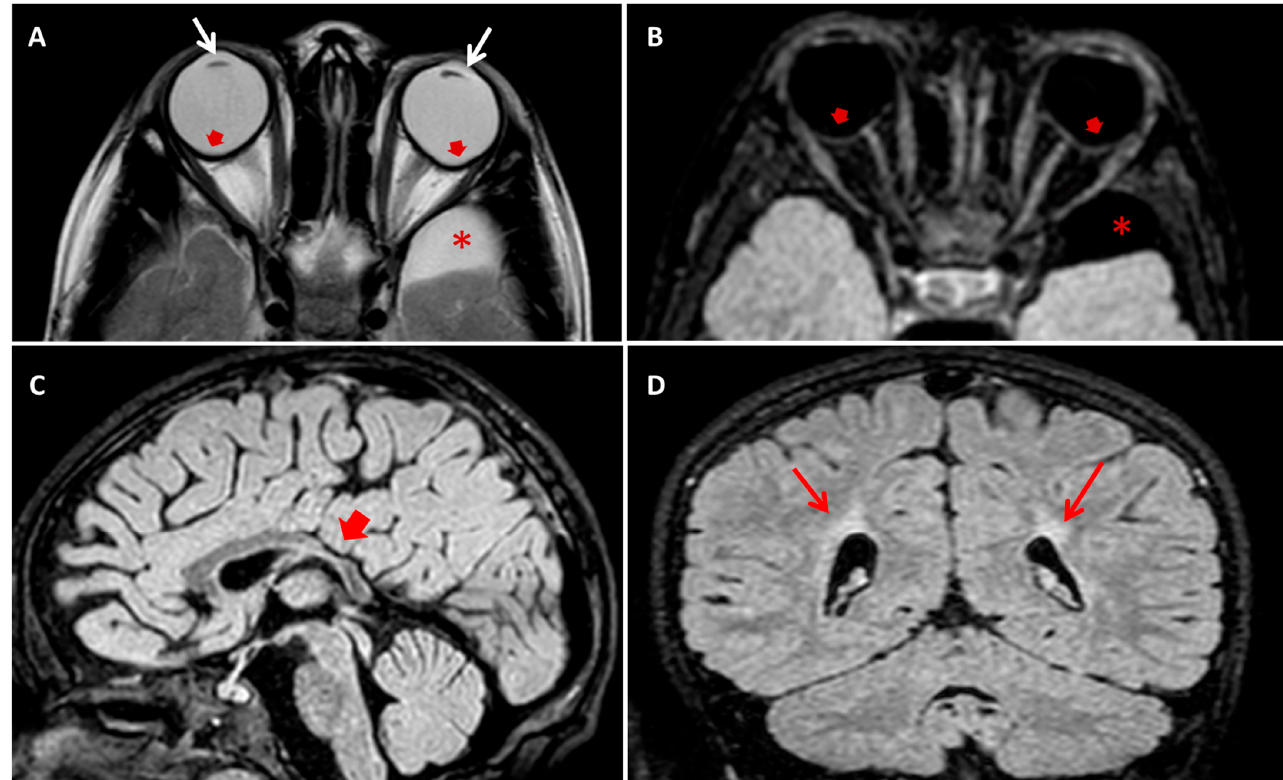
Figure 1. ( A ) Pedigree of the family. ( B ) Dental anomalies of the patient, including notching of incisors and supernumerary teeth (right and left panel). ( C ) Note the mild dyschromia of sub ‐ ungual space. ( D ) Schematic representation of the NHS gene with the p.C125X hemizygous variant identified in the exon 1 of the gene.